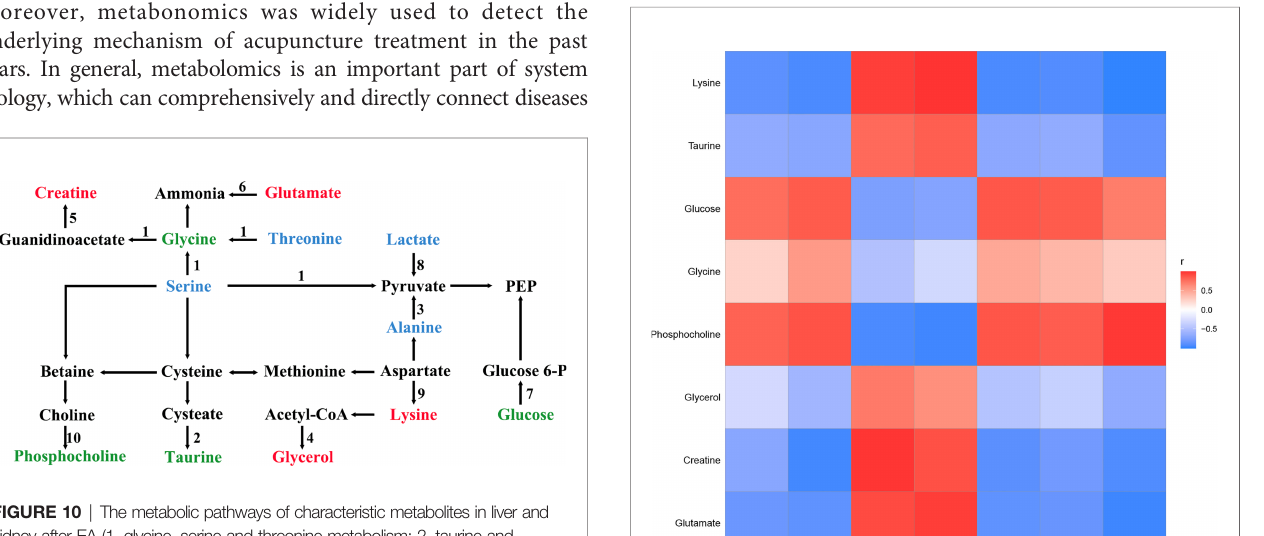
FIGURE 10 | The metabolic pathways of characteristic metabolites in liver and kidney after EA (1, glycine, serine and threonine metabolism; 2, taurine and hypotaurine metabolism; 3, alanine, aspartate, and glutamate metabolism; 4, glycerolipid metabolism; 5, arginine and proline metabolism; 6, arginine biosynthesis; 7, glycolysis/gluconeogenesis; 8, pyruvate metabolism; 9, lysine degradation; 10, glycerophospholipid metabolism; green shows metabolites in liver; blue shows metabolites in kidney; red shows metabolites in liver and